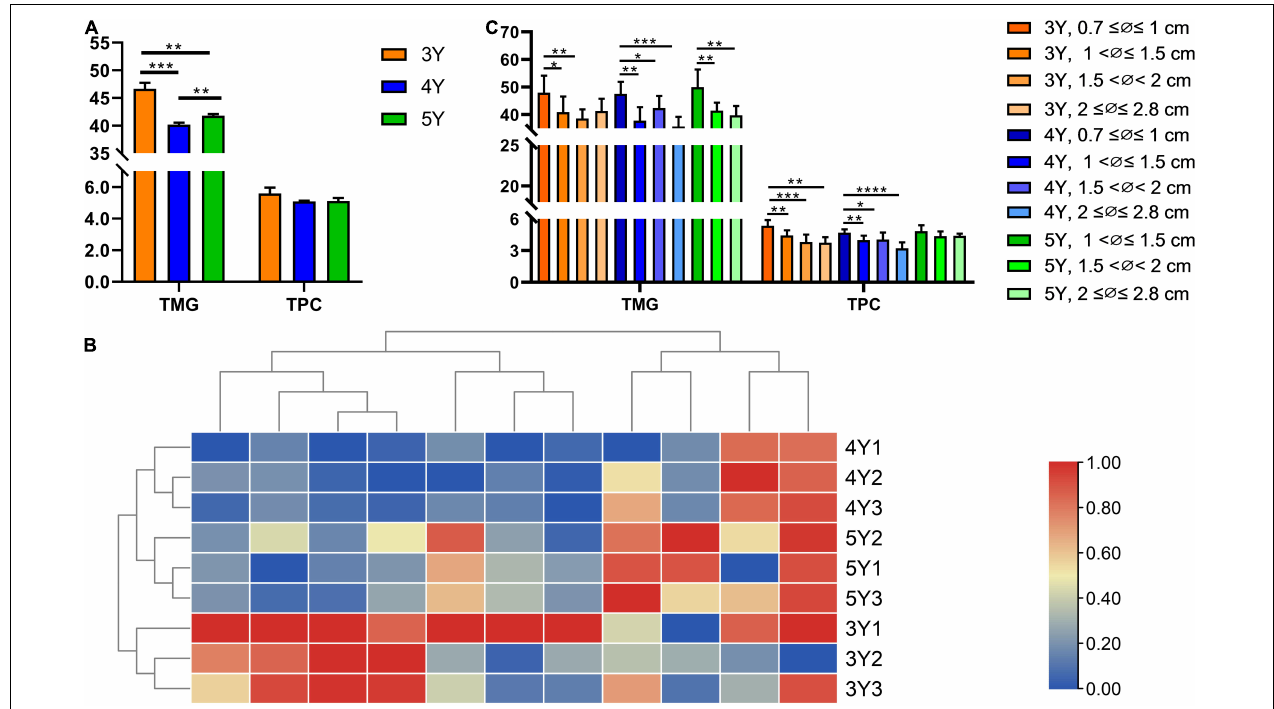
FIGURE 4 | Contents of 11 reference compounds in P. lactiflora roots of different ages (A,B) and different diameters (C) . TMG, total content of five monoterpene glycosides; TPC, total content of six phenols. * p < 0.05, ** p < 0.01, *** p < 0.001, **** p <